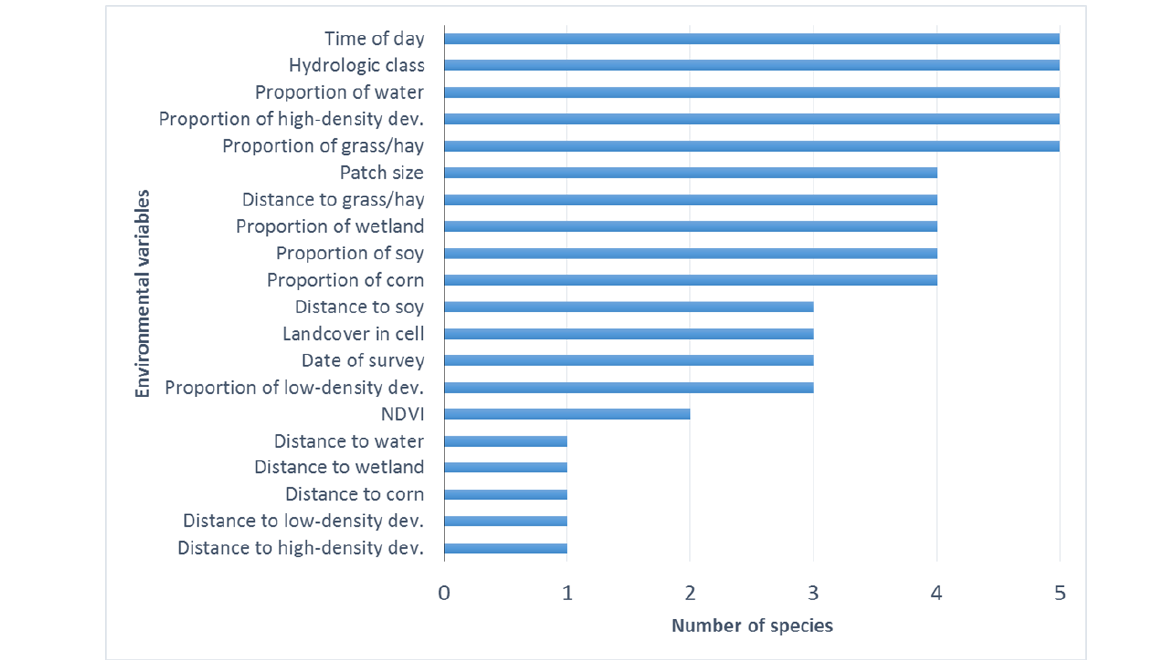
Figure A1.3. Frequency at which environmental variables were included in models of relative avian abundance for five species of grassland birds.